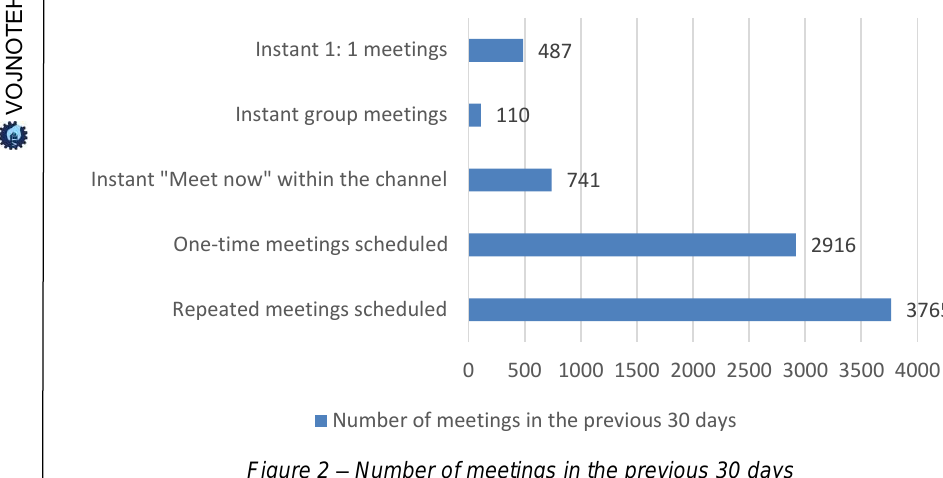
Figure 2 – Number of meetings in the previous 30 days Слика 2 – Број састанака у претходних 30 дана Рис. 2 – Количество встреч за предыдущие 30